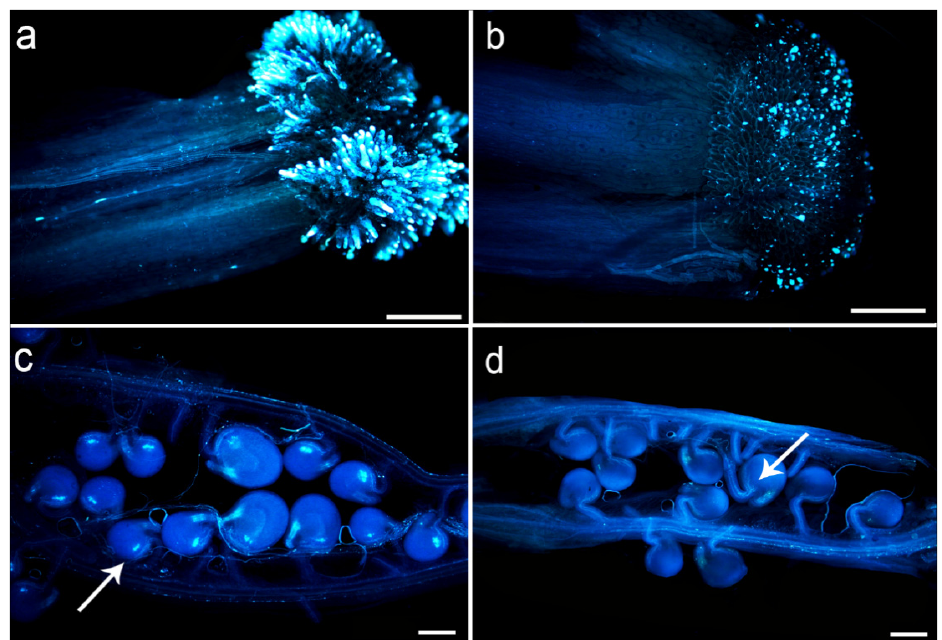
Figure 3. The adhesion of the stigma of each hybrid combination to pollen after 24 h of pollination and the observation of pollen tube extension in the silique after 48 h of pollination: ( a ) Y3380 pollen was pollinated on T19-5 stigma; ( b ) T19-5 pollen was pollinated on T19-5 stigma. ( c ) The extension of the pollen tube in the silique after the Y3380 pollen was pollinated on the T19-5 stigma for 48 h, the arrow indicates that the pollen tube entered the bead hole and complete fertilization. ( d ) The extension of pollen tube in the silique after pollination of T19-5 pollen on the stigma of T19-5 for 48 h. The arrow indicates that the pollen tube entangled and piled up near the bead hole and could not enter the bead hole to complete fertilization. Ruler = 1 mm.